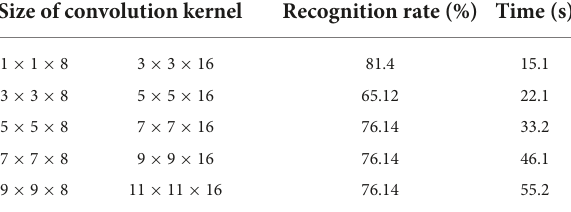
TABLE 2 The recognition results of audience expressions. Size of convolution